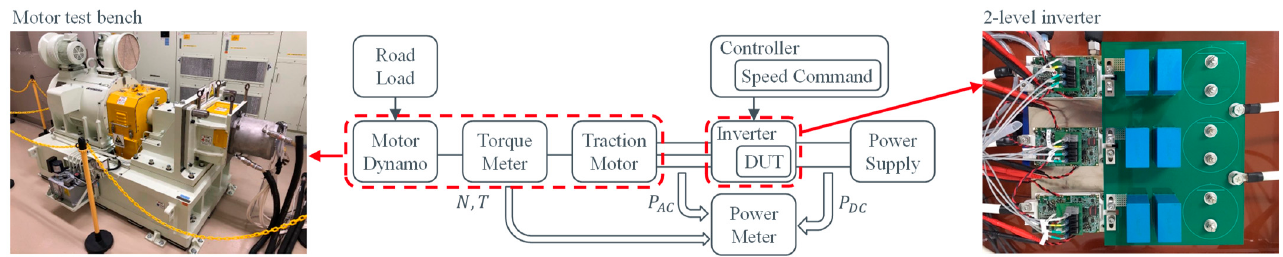
Figure 1. System con fi guration diagram.